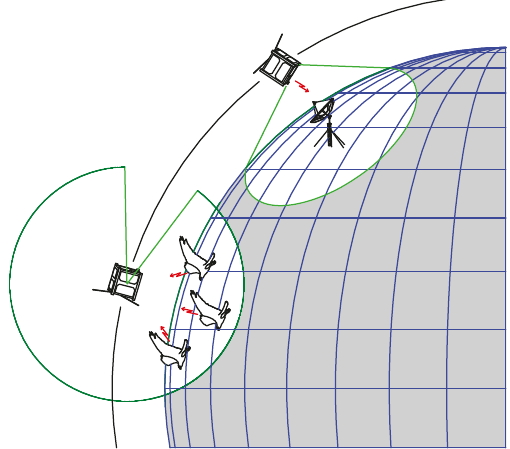
Figure 2: The ConOps of the DTUsat-2 system. The GPPLs are carried by migrating cuckoos, the PPL is on-board the space segment (DTUsat-2), and the GS handles the mission operation and data reception. Antenna coverage of both the payload and the COM system are